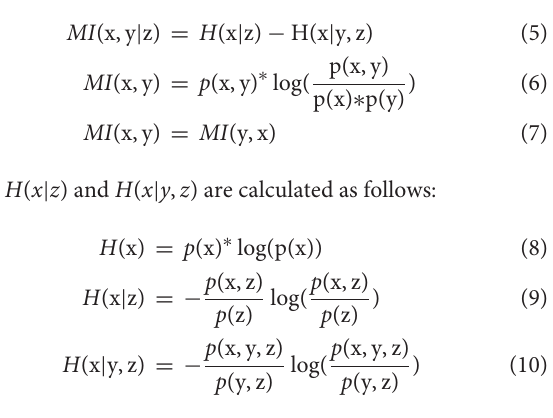
Here, ϕ denotes the 20 amino acid residues {A, C, D, E, F, G, H, I, K, L, M, N, P, Q, R, S, T, V, W, Y}. F ϕ represents the row sum